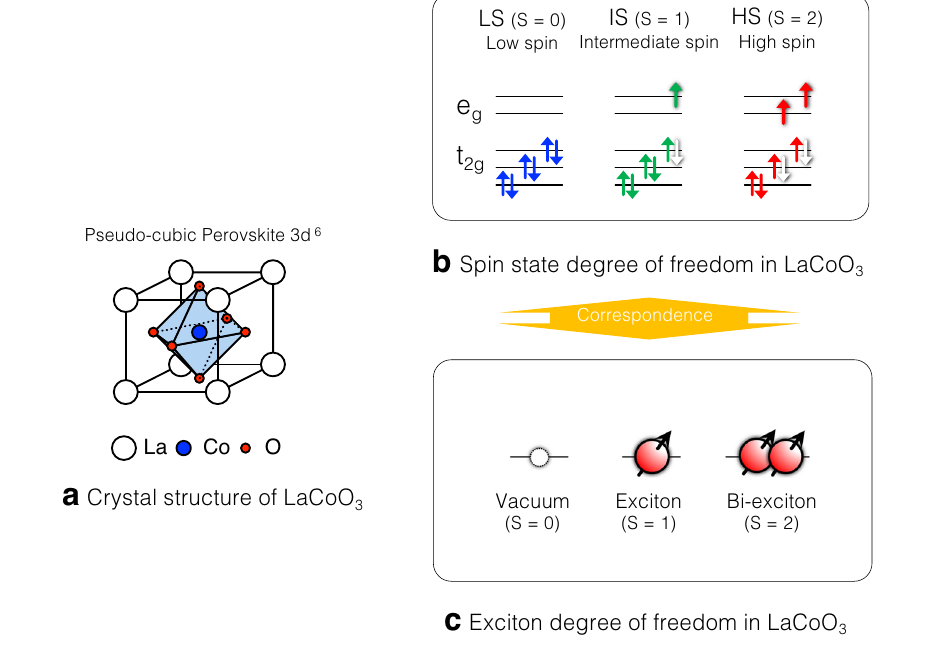
drawing of excitonic degrees of freedom in LaCoO 3 . LS and a pair of shaded elec- tron and hole in ( b ) correspond to vacuum and an exciton in ( c ),